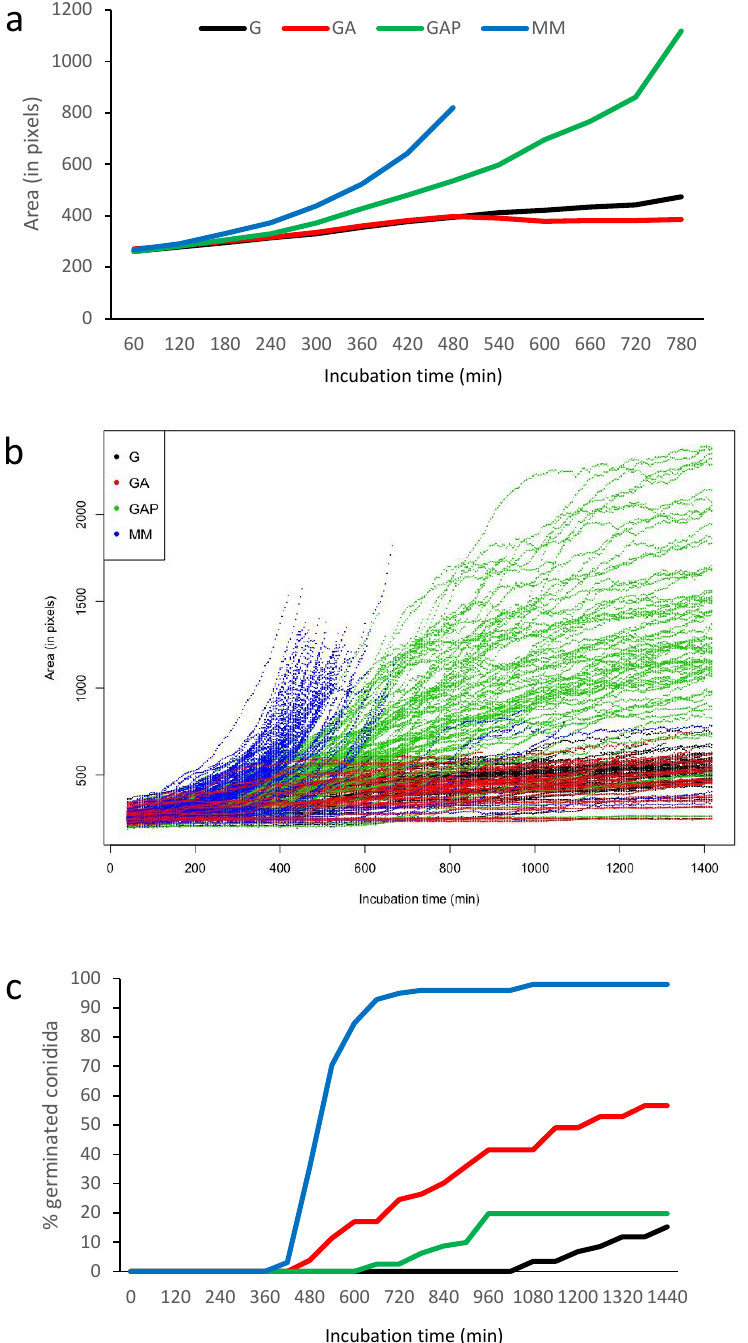
Figure 4. Quantification of the conidium germination in G, GA, GAP and MM media. ( a ) Average size in the different media until the emission of the first germ tube (computed as conidial surface estimated by pixels); ( b ) heterogeneity of germination with 100 swollen conidia (until the emission of the first germ tubes) randomly selected; ( c ) percentage of germinated conidia with germ tubes.